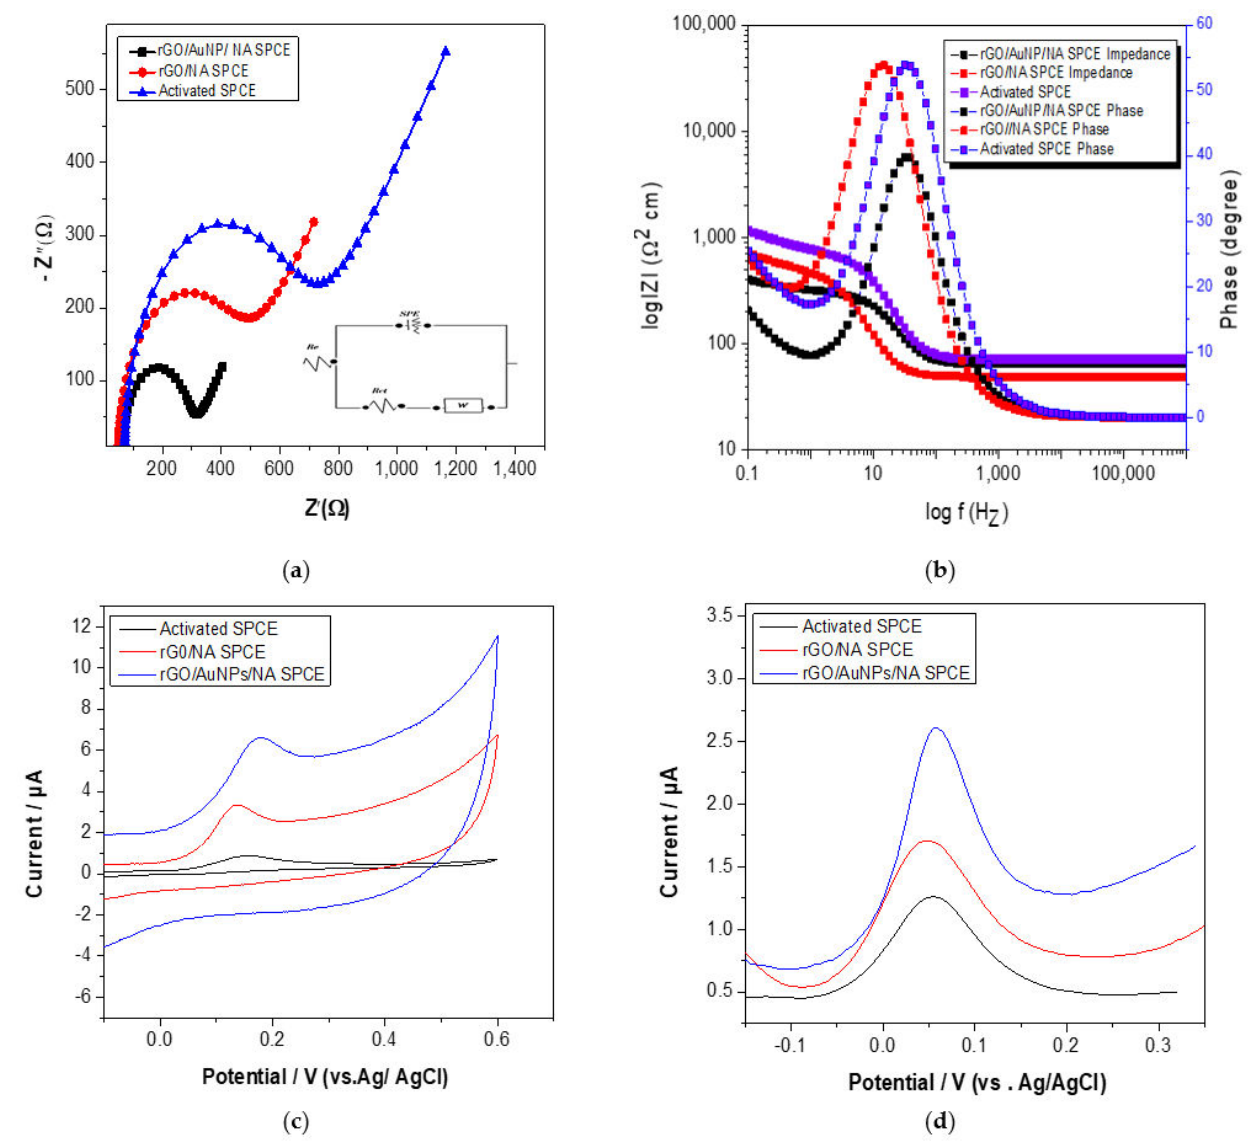
Figure 7. Nyquist plots ( a , b ) bode plots of EIS for activated SPCE, rGO/NA SPCE and rGO/AuNP/NA SPCE using 1 mM K 3 [Fe(CN) 6 ] in 0.1 M of KCl. Cyclic voltammograms ( c ) and DPV ( d ) of 200 µ M carbaryl in 0.1 M acetate buffer (pH = 5) at activated SPCE, rGO/NA SPCE and rGO/AuNP/NA